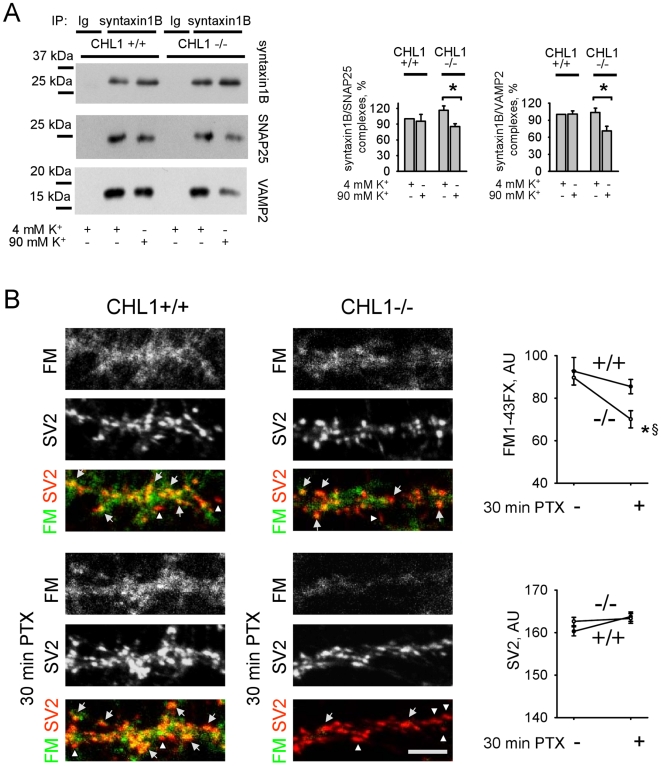
Sustainability of the synaptic vesicle recycling machinery is reduced in CHL1−/− neurons.
A - Syntaxin1B immunoprecipitates (IP) from CHL1+/+ and CHL1−/− synaptosomes, treated with 4 mM or 90 mM K+, were probed by Western blot with antibodies against synataxin1B, SNAP25 and VAMP2. Graphs show mean optical densities of the blots ± SEM (n = 6) with the levels of SNAP25 and VAMP2 that co-immunoprecipitate with syntaxin1B from 4 mM K+ treated CHL1+/+ synaptosomes set to 100%. Exposure to 90 mM K+ reduces levels of SNAP25 and VAMP2 that co-immunoprecipitate with syntaxin1B from CHL1−/− synaptosomes. *p<0.05, paired t-test (compared as indicated). B - CHL1+/+ and CHL1−/− cultured hippocampal neurons that were either non-treated or pre-incubated with 50 µM PTX for 30 min were then incubated with PTX for 10 min in the presence of FM1-43FX. After fixation, neurons were co-labeled with antibodies against SV2. Note FM1-43FX loaded (yellow on overlay images, arrows) and non-loaded (red on overlay images, arrowheads) SV2 positive synaptic boutons. Note, that FM1-43FX non-loaded synapses are present in all groups. However, number of FM1-43FX non-loaded synapses is increased and levels of FM1-43FX in FM1-43FX loaded synapses are reduced in CHL1−/− versus CHL1+/+ neurons pre-treated with PTX. Graphs show mean FM1-43FX and SV2 fluorescence levels ± SEM in SV2 accumulations (N>30 images of neurons with n>200 SV2 positive synaptic boutons per image were analyzed in each group). *,§ p<0.05, t-test (PTX stimulated CHL1−/− versus CHL1+/+ neurons (*), and PTX stimulated versus non-stimulated neurons of the same genotype (§) were compared).